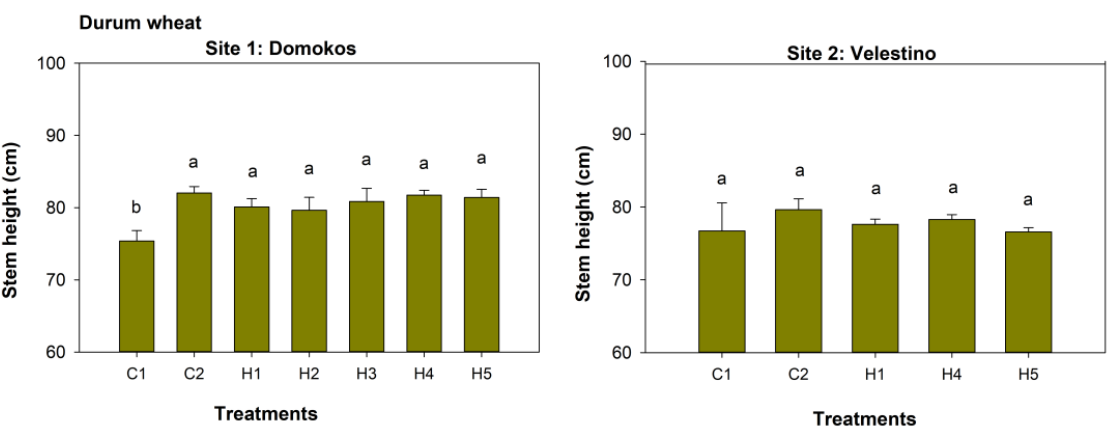
Figure 5. Herbicide treatment (C1: untreated control, C2: weed-free control, H1: metsulfuron- methyl + bensulfuron-methyl, H2: pyroxsulam/florasulam + 2,4-D, H3: aminopyralid + florasulam, H4: bromoxynil + 2,4-D, and H5: halauxifen-methyl + florasulam) effects on relative chlorophyll content (SPAD values) at two sites. Values are presented as means of three replicates ± standard deviation. Mean values followed by different letters have statistically significant differences according to Duncan’s multiple range test at p < 0.05. F values of ANOVA: F = 26.474 *** (Site 1: Domokos) and F = 11.126 ** (Site 2: Velestino). ** and *** significant at p < 0.01 and p < 0.001.